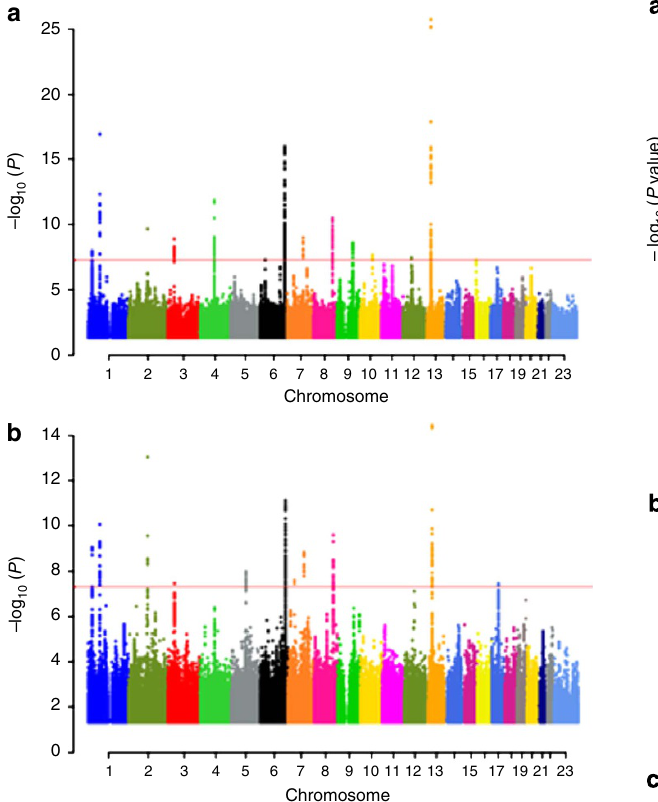
Figure 1 | Manhattan plot of discovery genome-wide association study. The P values ( (cid:3) log 10 ) are plotted against their respective positions on each chromosome. P ¼ 5 (cid:2) 10 (cid:3) 8 is indicated by the horizontal pink line. The plots were created using qqman: an R package for visualizing GWAS results using Q-Q and Manhattan plots 46 . ( a ) Results for spine BMD. The P values of the associations are given within brackets at each locus: 1p36.12 ( P ¼ 1.08 (cid:2) 10 (cid:3) 8 ), 1p31.3 ( P ¼ 1.11 (cid:2) 10 (cid:3) 17 ), 2q14.2 ( P ¼ 2.28 (cid:2) 10 (cid:3) 10 ),